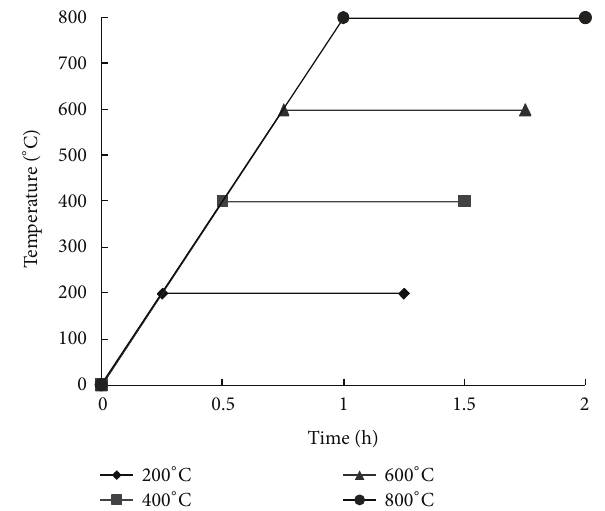
Figure 2: Heating regime for ECC